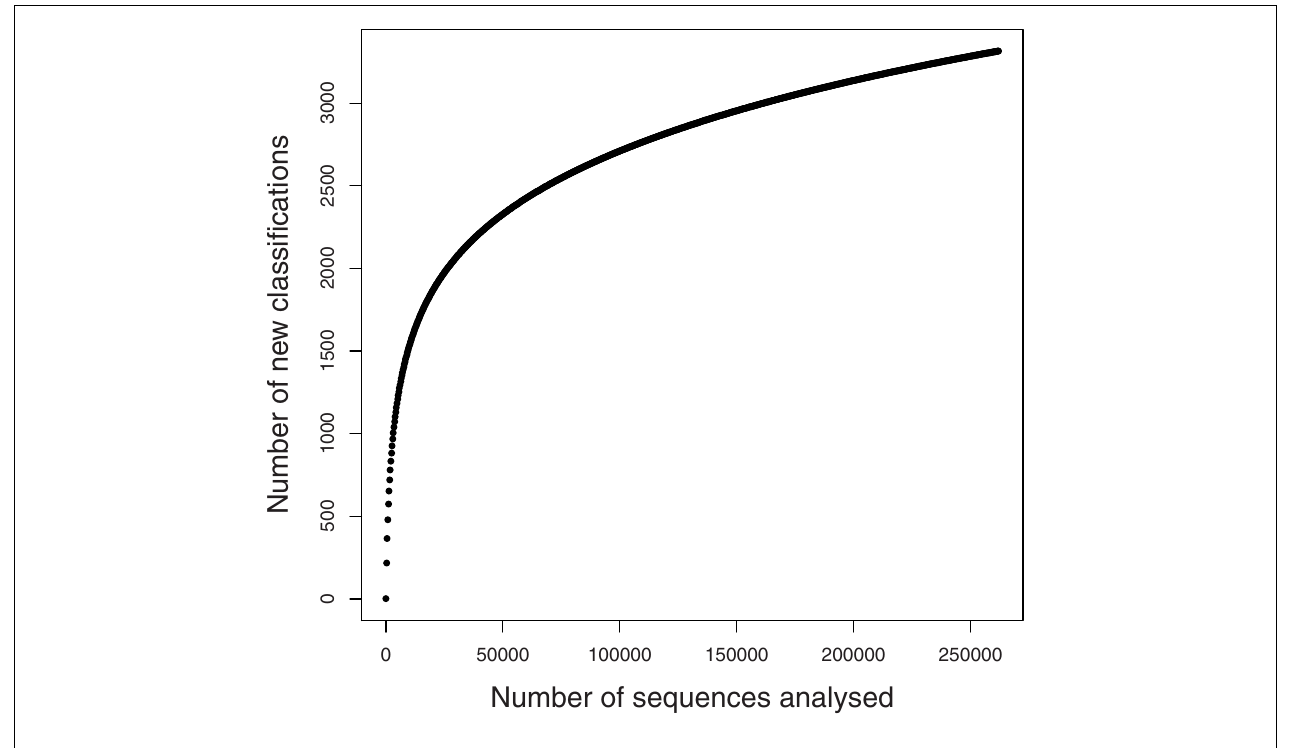
FIGURE 2 | Rarefaction graph from SEED data.